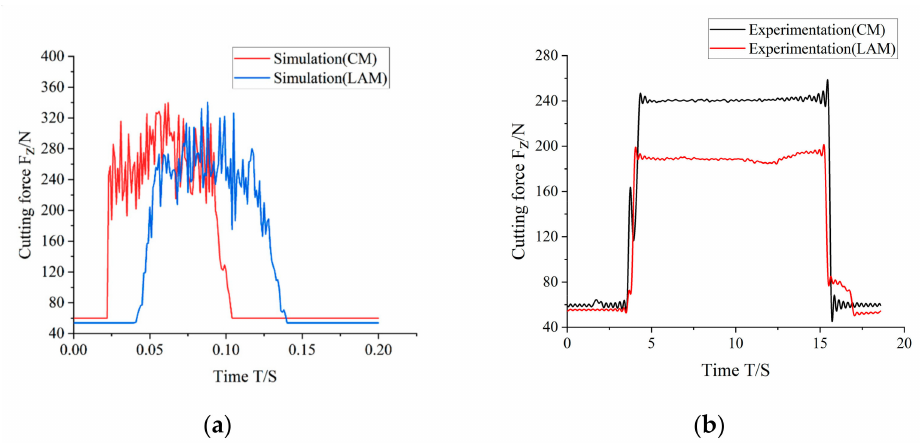
Figure 4. Comparison of simulated and experimental cutting forces curves: ( a ) simulation; ( b ) experi-